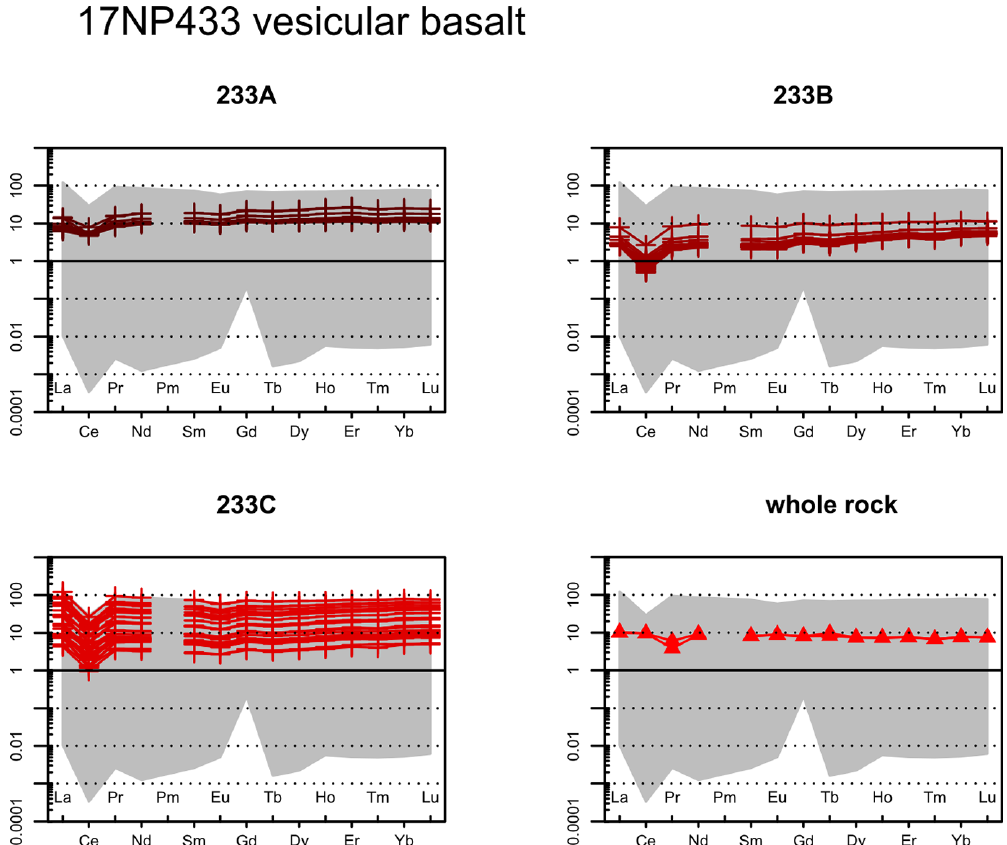
Figure C3. Rare earth element plots of each individual ablation area for sample 15NP233. Whole rock data from Rembe et al. (2021). Grey shaded area in each diagram represents the range of chondrite-normalized REE concentrations in all calcite ablation